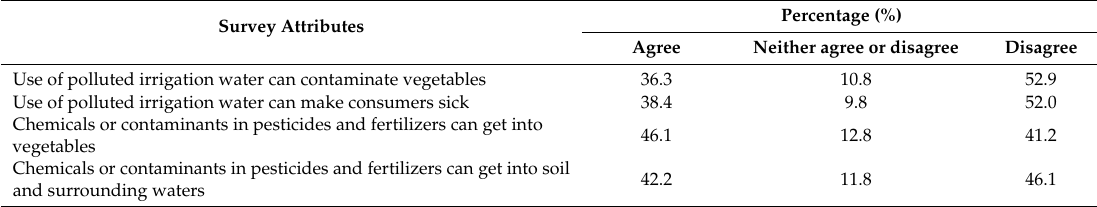
Table 6. General food safety knowledge of participating vegetable farmers in Accra,